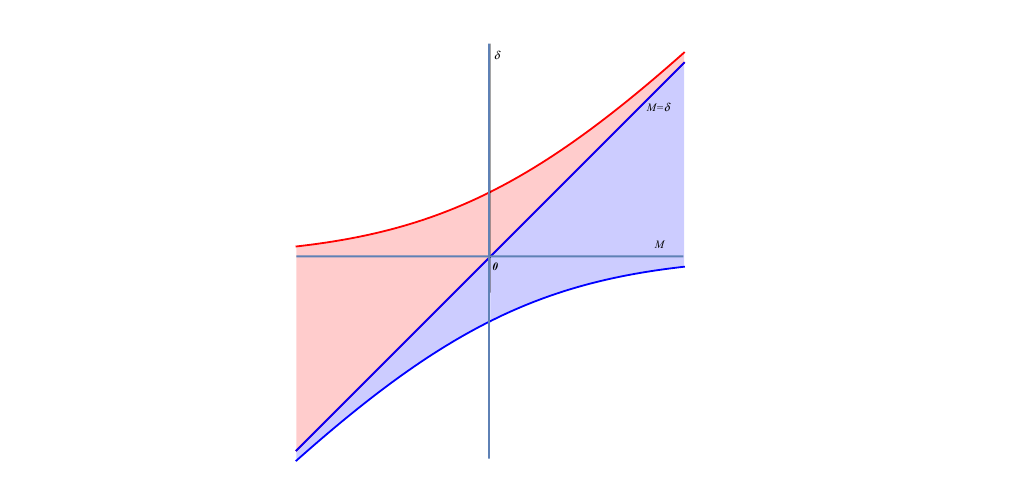
Figure 1. Regions of positive and negative signs of the Green’s function in the plane M × δ . The blue region represents the positive sign of the Green function G , while the red region corresponds to the negative sign of Green’s